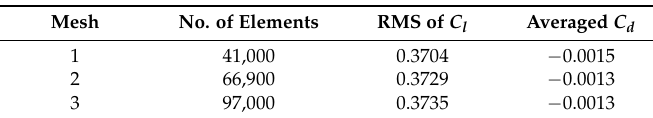
Table 1. Mesh convergence results.